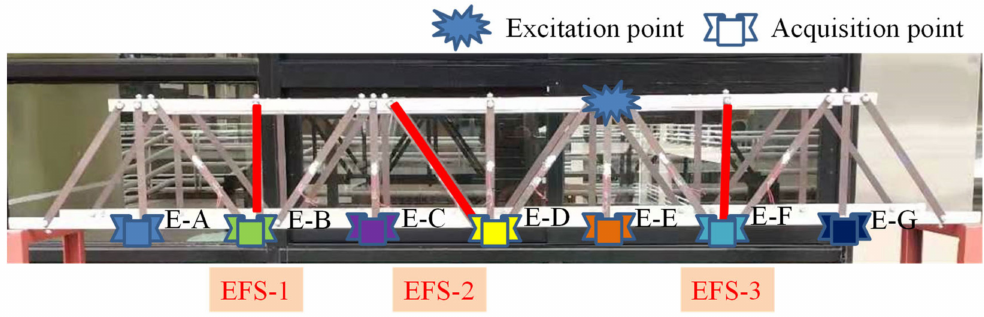
Figure 9. Distribution of the damage locations and accelerometers (bridge